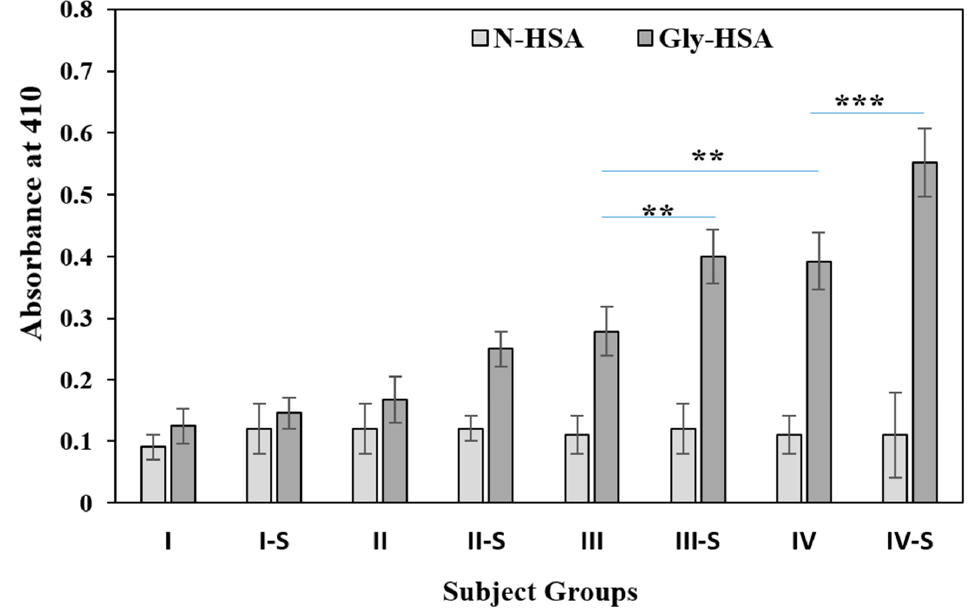
Figure 2. Anti-Gly-HSA-Abs were detected by direct binding ELISA form serum samples (1:100 diluted) of all the subjects in di ff erent groups. Groups were divided based on age and smoking habits; group I (21–40), I-S (21–40), II (41–60), II-S (41–60), III (61–80), III-S (61–80), IV ( > 80) and IV-S ( > 80). ‘S’ in the group represent subjects who are smokers. Data presented as mean ± SD. t test was adopted for the comparison between the two groups and significance is defined as ** p < 0.01, *** p < 0.001. The comparison between group IV-S and IV showed p < 0.001. The comparison between III-S and III showed p < 0.01. The comparison between IV and III showed p < 0.01.